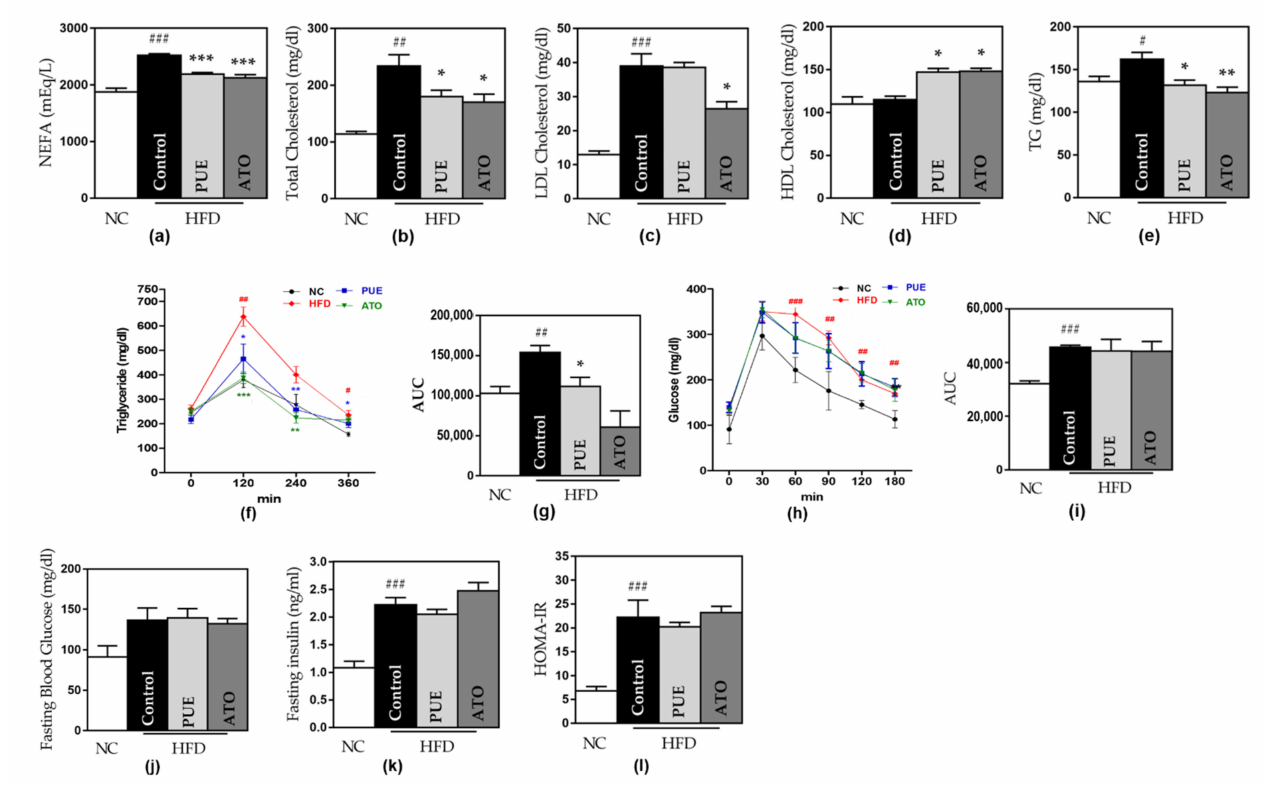
Figure 4. Lipid and glucose metabolism. ( a ) NEFA, ( b ) total, ( c ) LDL cholesterol, ( d ) HDL